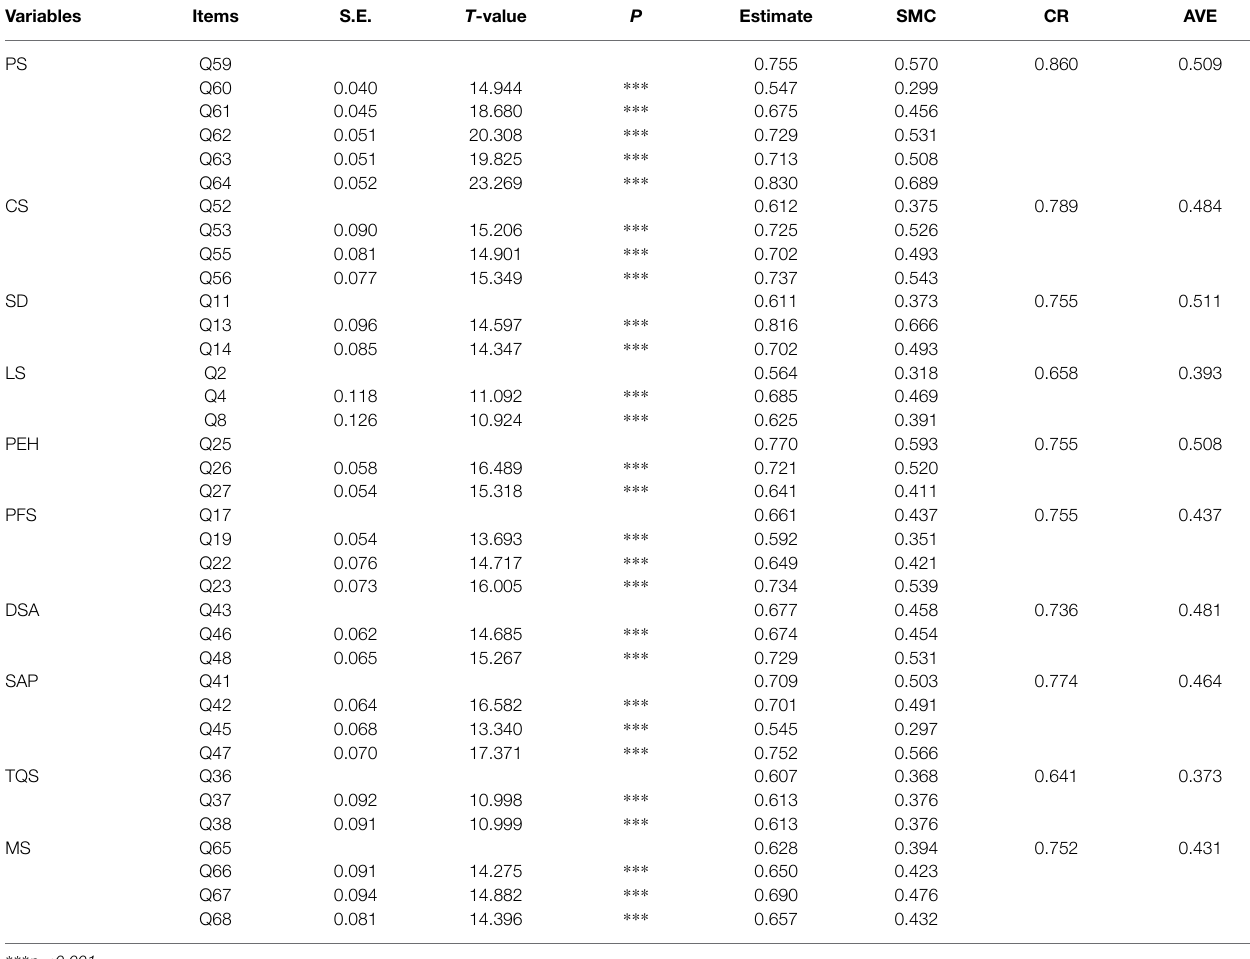
TABLE 5 | Table of reliability and convergent validity.